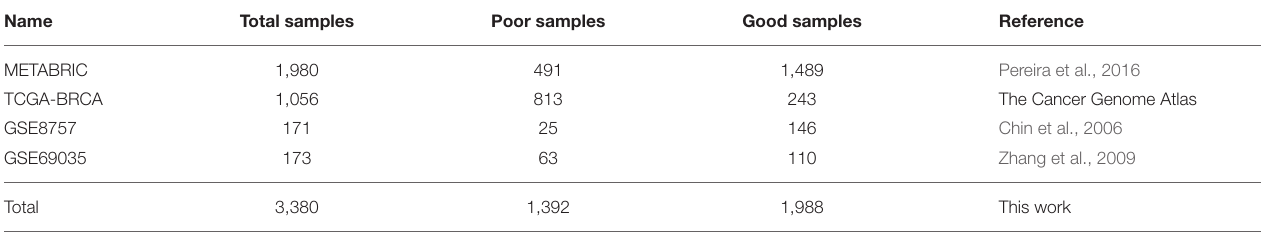
TABLE 1 | Summary of breast cancer datasets.